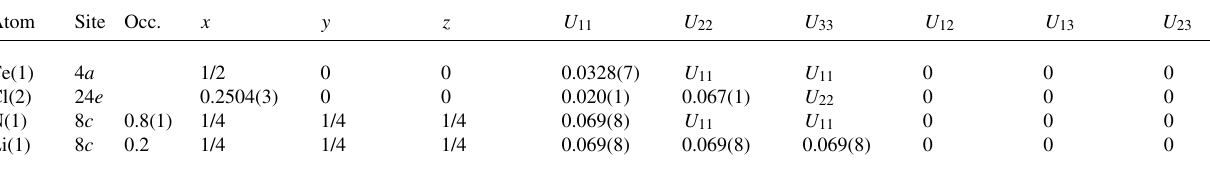
Table 3. Atomic coordinates and displacement parameters (in Å 2 ) .